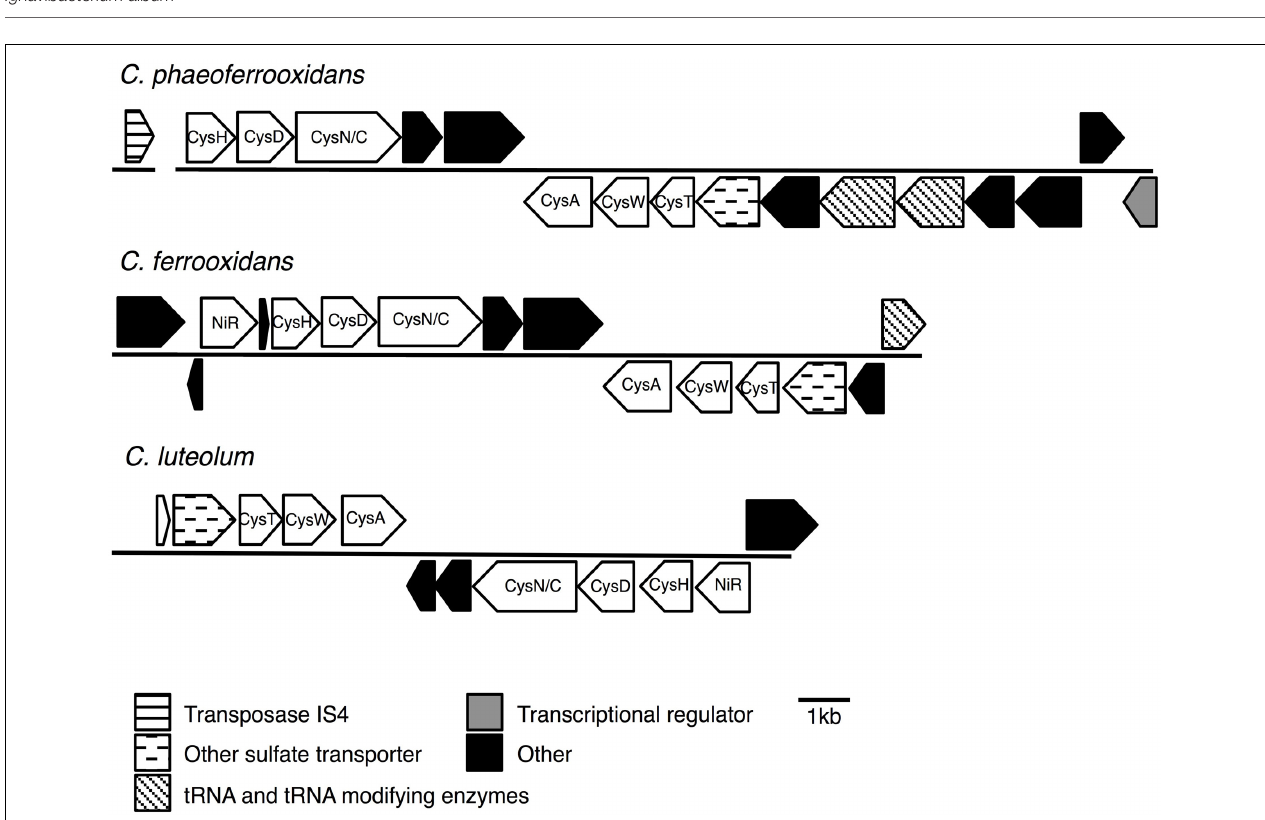
FIGURE 5 | Assimilatory sulfate reduction (ASR) gene cassettes for the photoferrotrophic Chlorobi, detailing the position of each gene and the differences and similarities between the gene cassettes.